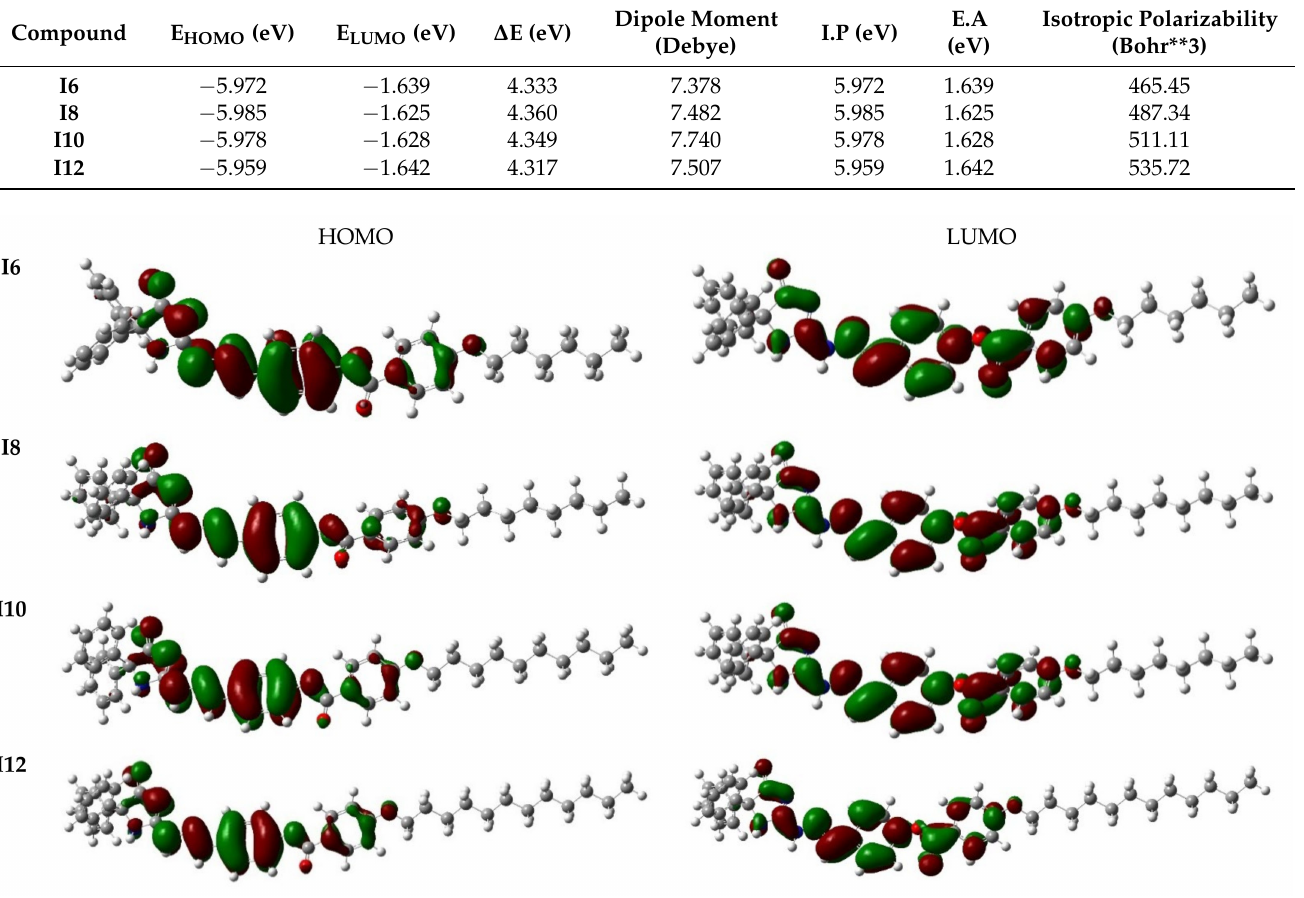
Figure 4. FMO’s computed at B3LYP/6-31g(d,p) level of series In .